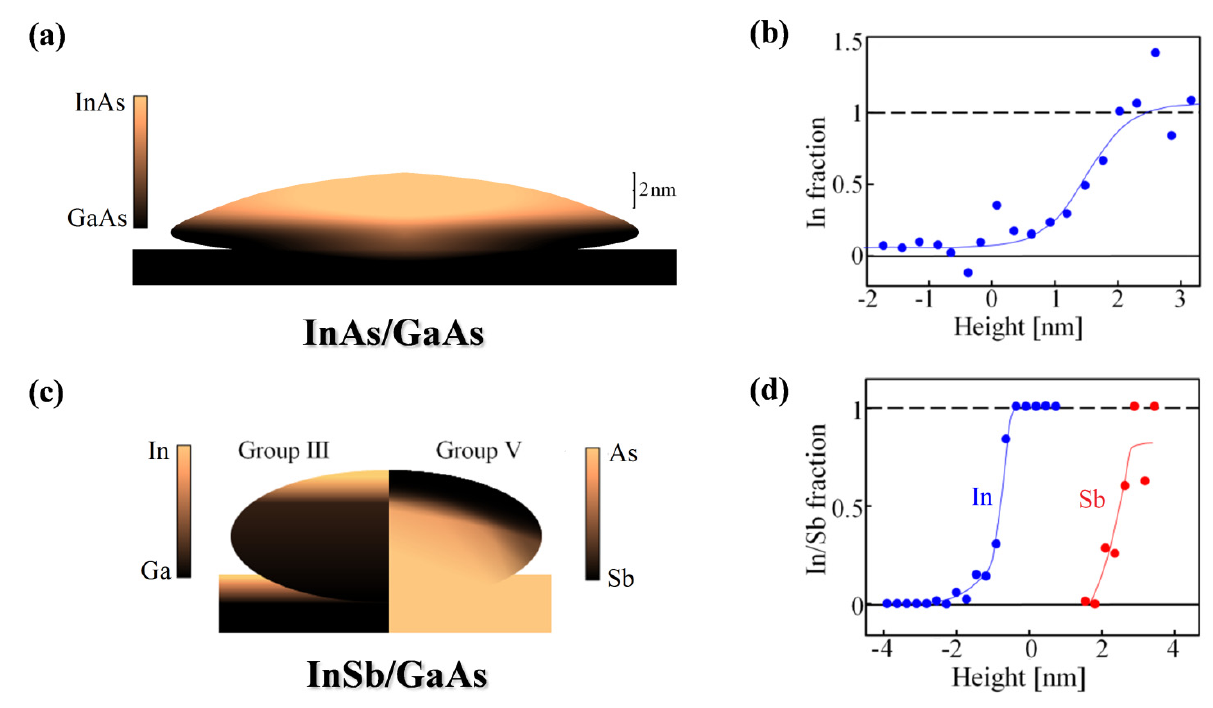
Figure 3. Compositional schemes of the different dot systems. ( a ) Shape and chemical composition map of InAs/GaAs QD. ( b ) Average fractional occupancy of In in the In Ga As structure as a function of height from the dot-substrate interface. ( c ) x 1-x Composition map of InSb/GaAs QD. The left half shows the group III (In/Ga) elements occupancy, and the right half—that of group V (As/Sb). ( d ) Average fractional occupancy of In and Sb in the In Ga As Sb structure as a function of height from the x 1-x y 1-y dot-substrate